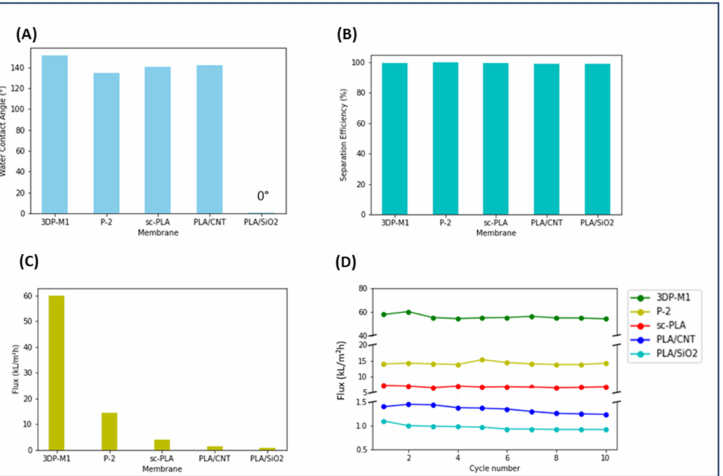
Figure 7. Separation performance of 3DP-M1 and conventional membranes. ( A ) Water contact angle. ( B ) Separation efficiency (n-hexane/water). ( C ) Permeation flux. ( D ) Permeation flux of n-hexane/water mixture for 10 separation